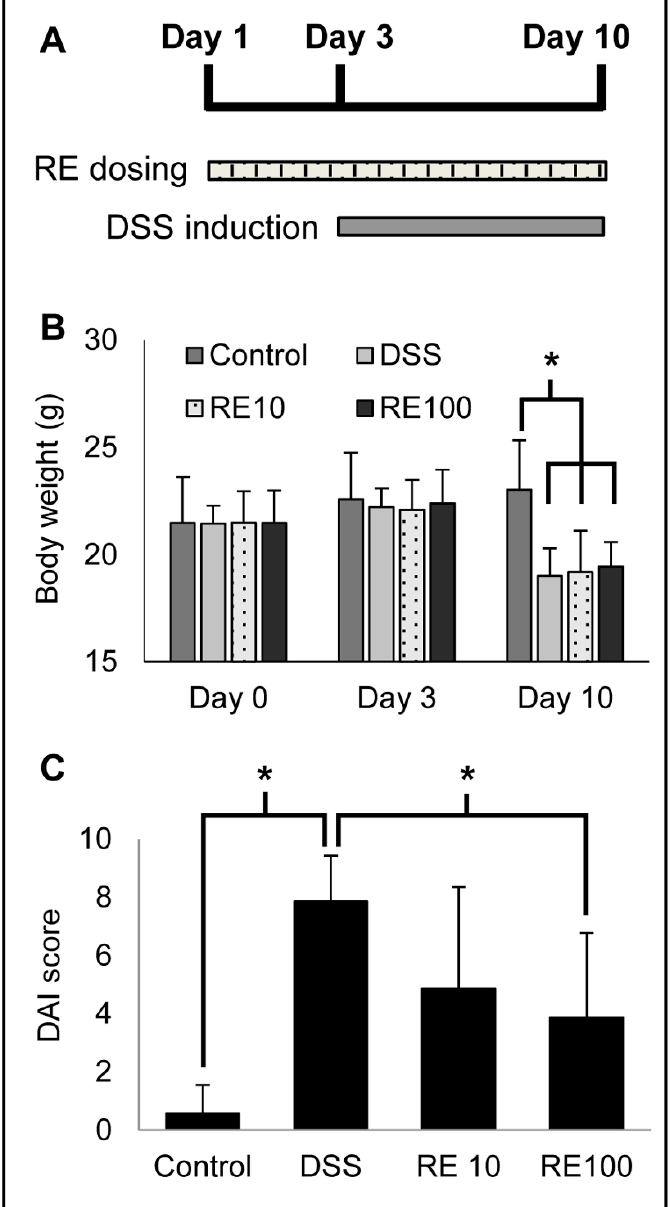
Figure 4. ( A ) Visual timeline of in vivo study. Mice were pre-treated with rosemary extract (RE) for 3 days prior to dextran sodium sulfate (DSS) administration for 7 days. Seven mice were included in each group. ( B ) Disease activity index (DAI) scores for DSS mice treated with RE ( n = 7 mice per group). Mice were scored according to parameters associated with colitis injury. The results show pre-treatment with RE100 improved DAI scores compared to DSS. ( C ) Body weight changes in DSS mice treated with RE ( n = 7 mice per group). Mice were weighed on day 0 (before RE administration), day 3 (before DSS administration), and day 10 (before sacrifice). One-way ANOVA followed by Tukey’s HSD test was used to determine significance. * p <